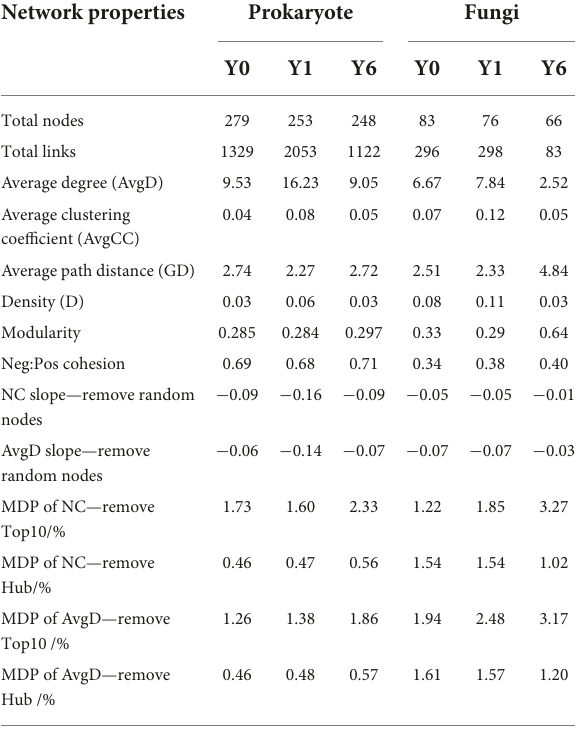
TABLE 2 Topological properties of prokaryotic and fungi interaction network. Network